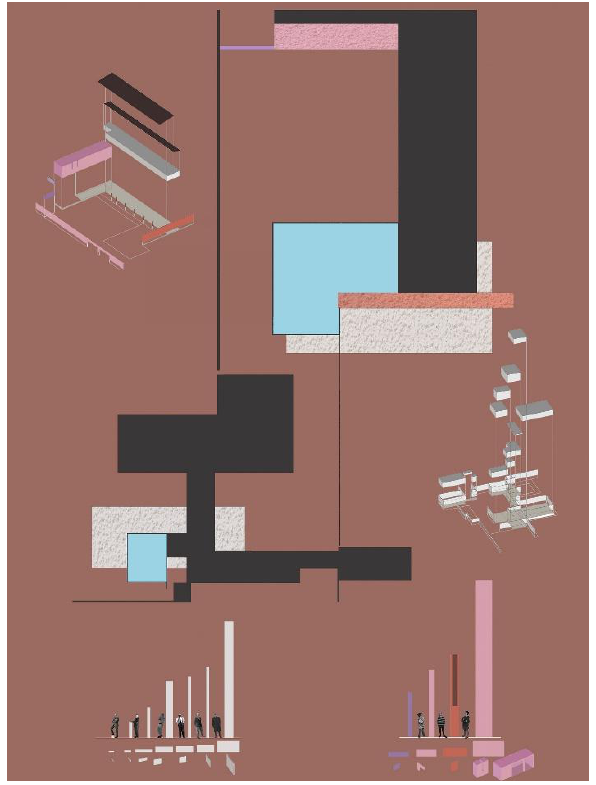
Figure 9. Luis Ramiro Barragán Morfín, Cuadra San Cristobál (1968), Atipazan, Messico. Project conceptualization